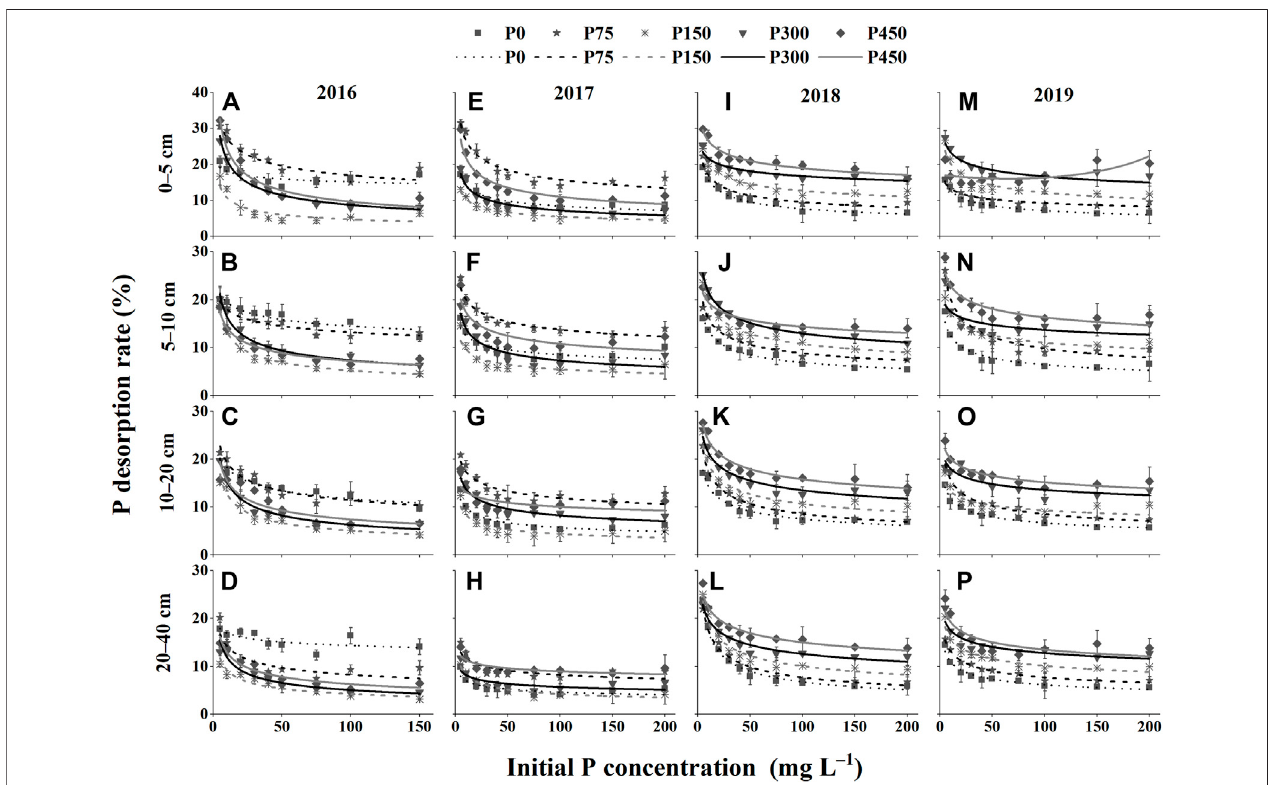
FIGURE 5 | Phosphate desorption rate of different treatments in 2016 – 2019. (A – D) 0 – 5, 5 – 10, 10 – 20, and 20 – 40 cm in 2016; (E – H) 0 – 5, 5 – 10, 10 – 20, and 20 – 40 cm in 2017; (I – L) 0 – 5, 5 – 10, 10 – 20, and 20 – 40 cm in 2018; and (M – P) 0 – 5, 5 – 10, 10 – 20, and 20 – 40 cm in 2019.